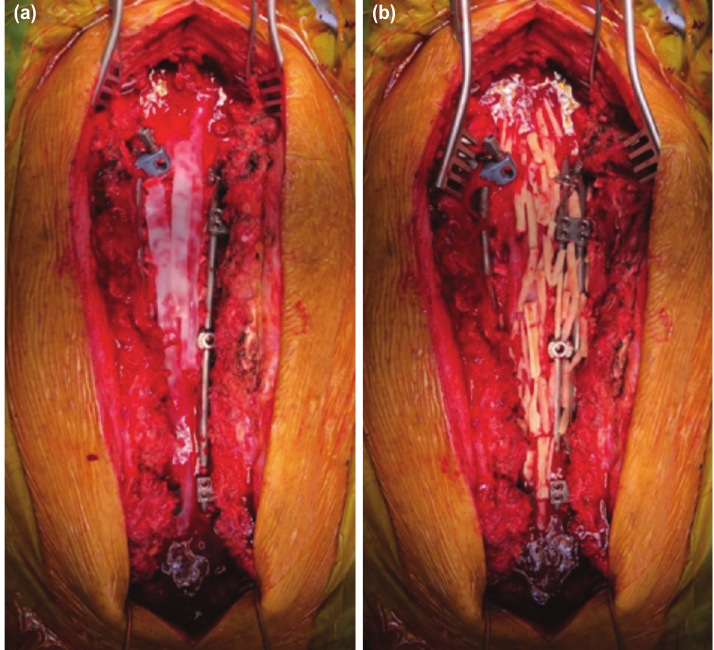
(a) Intra-operative photographs showing the rh-BMP-2 strips were applied over the layer of onlay autologous local bone graft Fig. 6: (b) and strips of autologous fibula bone graft were applied on top of the rh-BMP-2